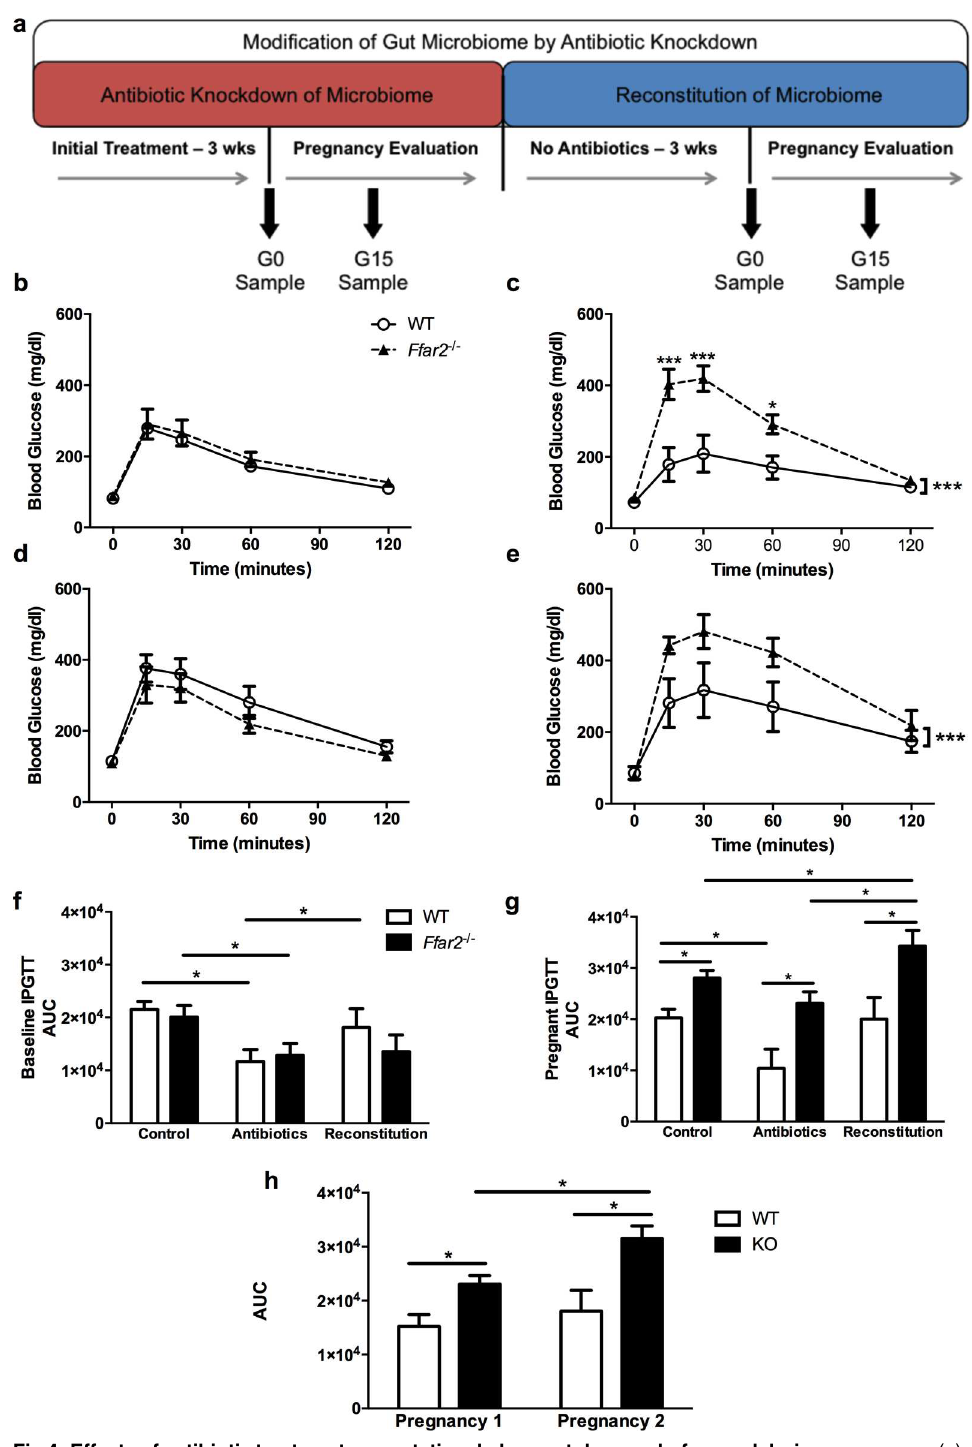
Fig 4. Effects of antibiotic treatment on gestational glucose tolerance before and during pregnancy. ( a ) Timelineof antibiotic treatment, pregnancy and reconstitution of the gut microbiotaof female mice, where the control group was WT ( Ffar2 +/+ ) mice and the experimental group was Ffar2 -/- mice. ( b-c ) Plasma glucose concentrations duringan IPGTT in antibiotic-treated mice at G0 ( b ) and at G15 ( c ). ( d-e ) Plasma glucose concentrations duringan IPGTT in mice after gut microbiomereconstitution at G0 ( d ) and G15 ( e ). ( f-g ) Comparisonof AUC values for plasma glucoseconcentrations duringan IPGTT administered to